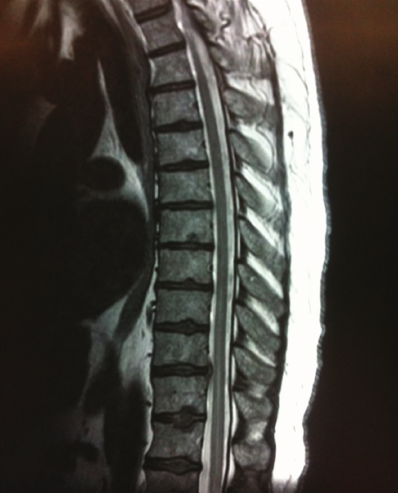
Figure 1: MRI thoracic spine showing acute spinal cord infarction. Sagittal T2-weighted MRI of the patient’s thoracic spine demon- strating nonspecific central intrinsic signal hyperintensity of the spinal cord located in conus region with extension to T8 level. Multilevel thoracic disc disease at T1 and T10-T11 is also present.